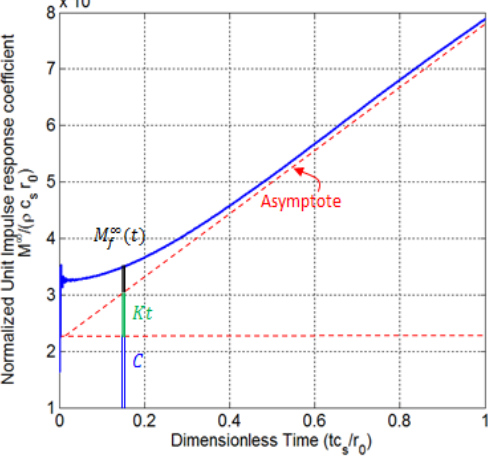
Figure 3. Typical acceleration unit-impulse response